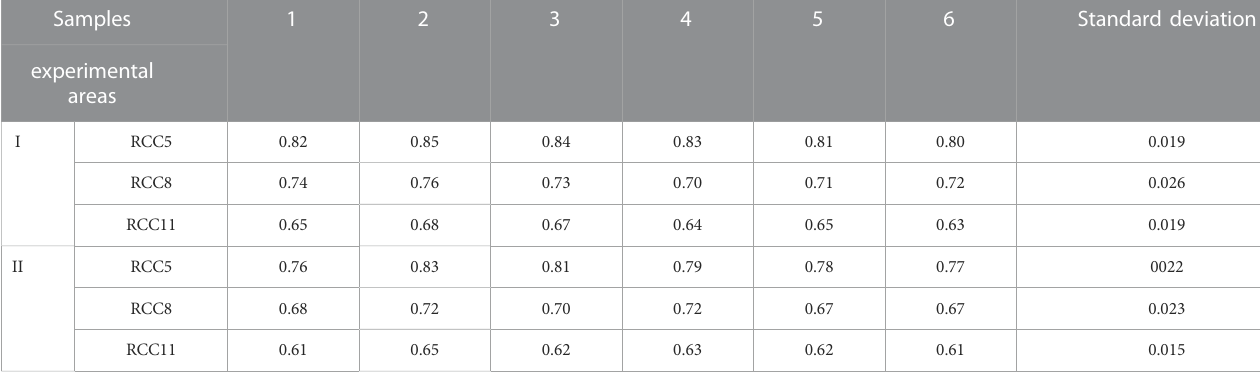
TABLE 10 Standard deviation based on RCC11 and String of each data in experimental area I and II. Samples experimental areas